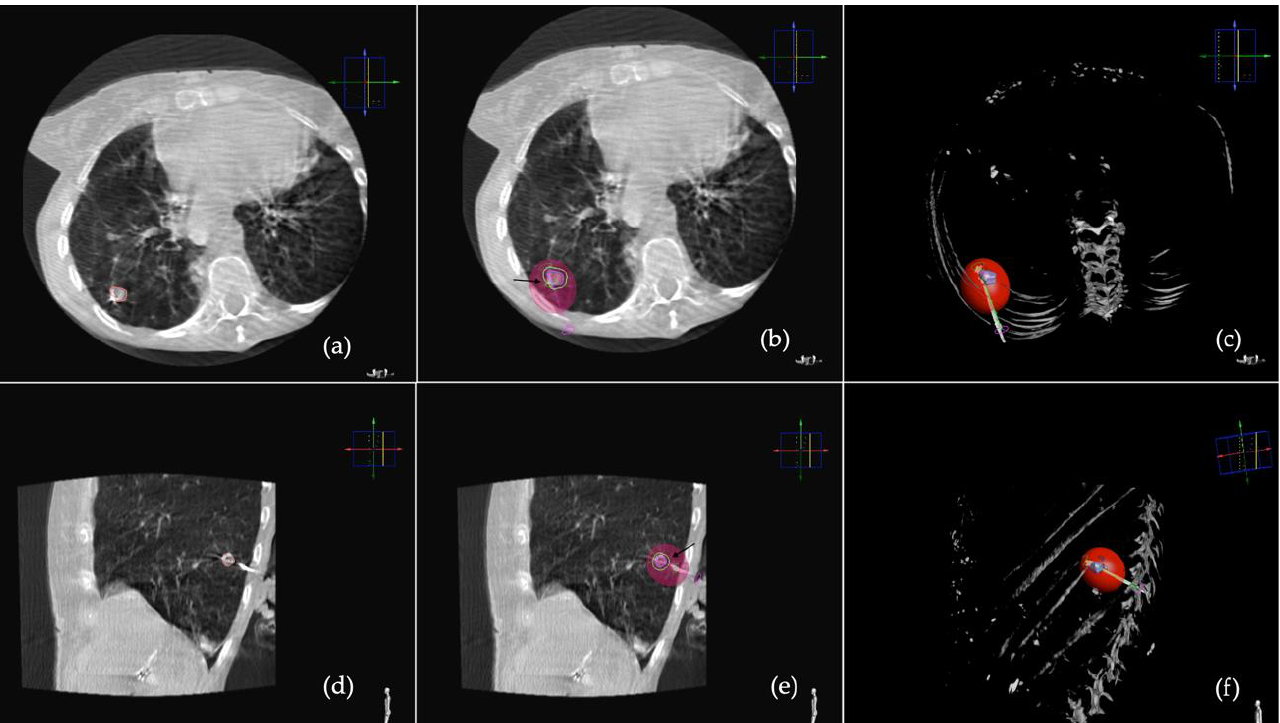
Figure 1. VPS was applied to CBCT images. ( a ) On axial and ( d ) sagittal CBCT scans the tumour has been segmented. ( b ) On axial and ( e ) sagittal CBCT scan, MWA is placed over the virtual one, the predicted ablation volume is seen as a purple ellipsoid and the green line (black arrow) shows that the predicted volume entirely encompasses the segmented lesion. ( c ) Axial and ( f ) sagittal 3D reconstruction of the lesion and predicted ablation volume.